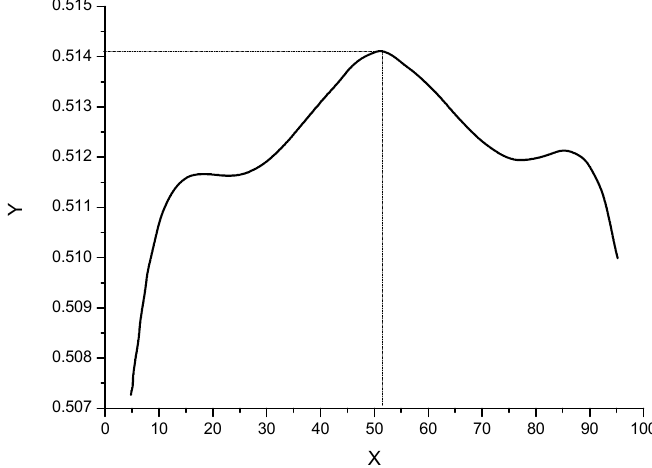
Figure 6. Curve of optimized objective function of Cu x Co 1 − x Fe 2 O 4 materials. Table 4. Optimal formula of spinel materials.